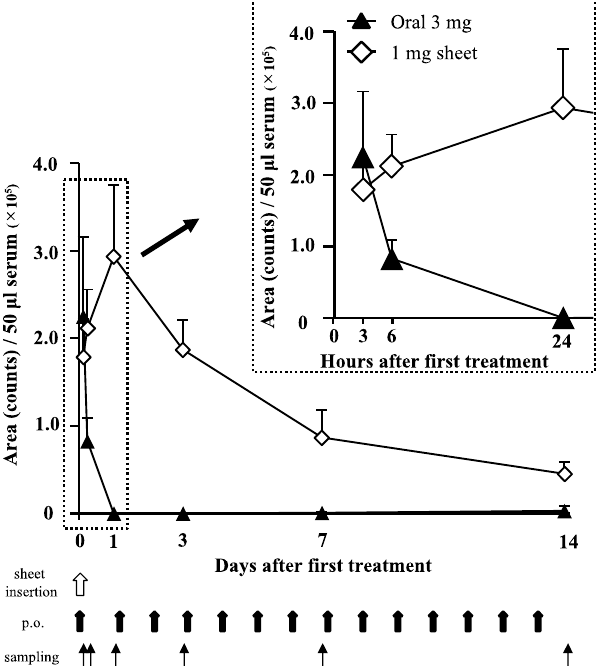
Figure 5. Trends of serum lenvatinib levels. The serum lenvatinib levels in the oral (filled triangle; 3 h: n = 5, 6 h: n = 5, day 1: n = 5, day 3: n = 5, day 7: n = 10, and day 14: n = 10) and 1 mg sheet (open diamond shape; 3 h: n = 5, 6 h: n = 5, day 1: n = 5, day 3: n = 5, day 7: n = 10, and day 14: n = 10)